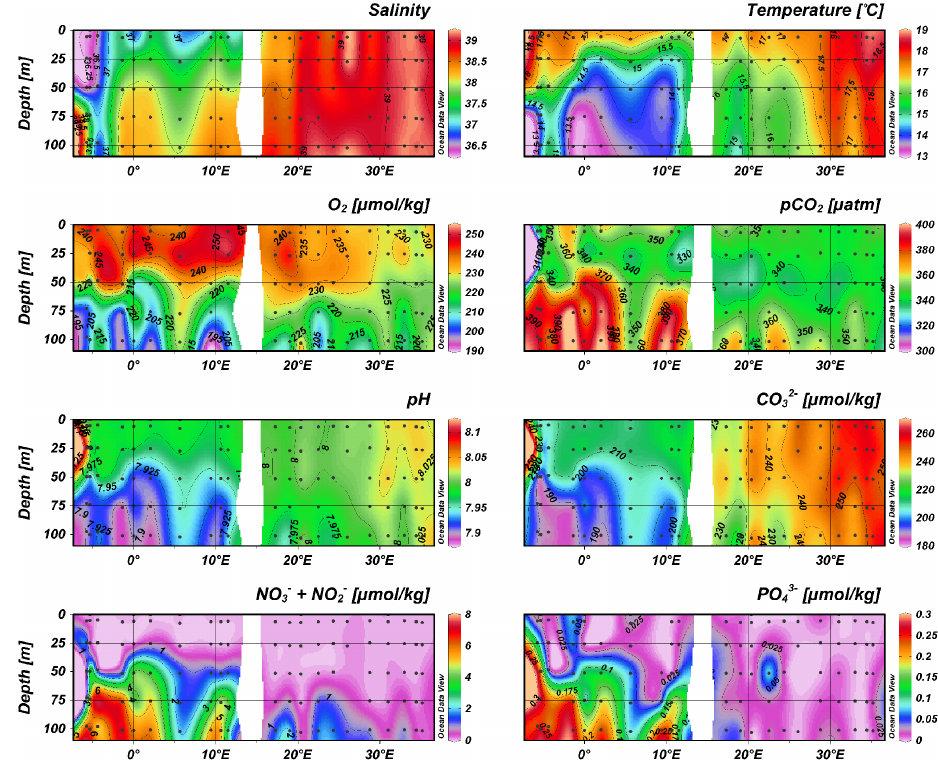
Figure 2. Environmental parameters at sampling stations for surface waters during the M84-3 cruise. The west–east transect along the Mediterranean Sea does not take into account the stations in the Aegean, Adriatic, the northernmost Ionian, or northern Tyrrhenian regions. It includes the stations labeled in black (west–east transect) in Fig.